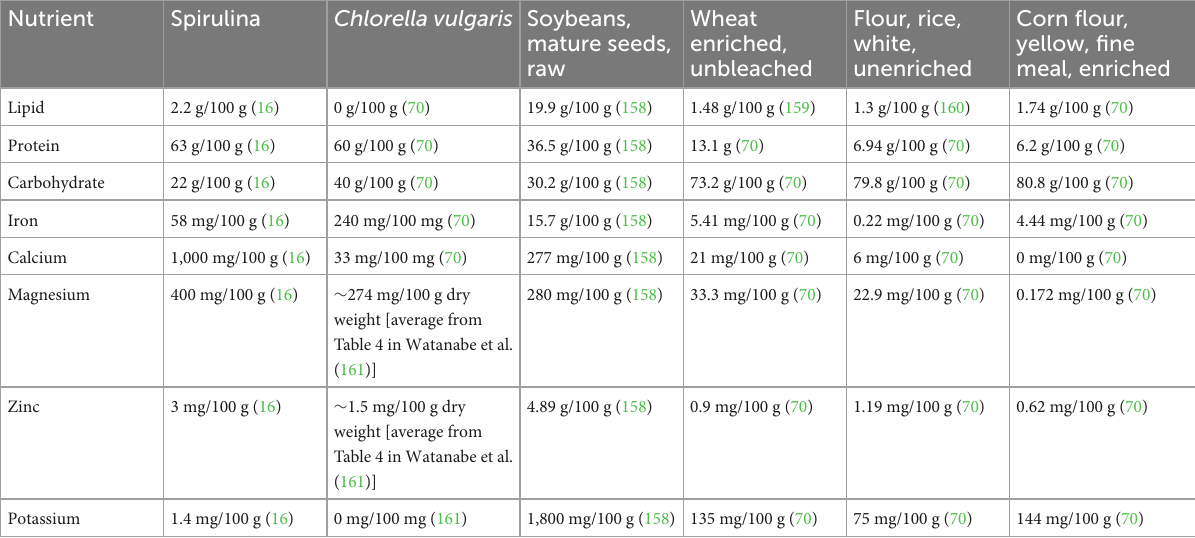
TABLE 1.1 Nutrient content comparison between algae and highly produced traditional crops. Nutrient Spirulina Chlorella vulgaris Soybeans,